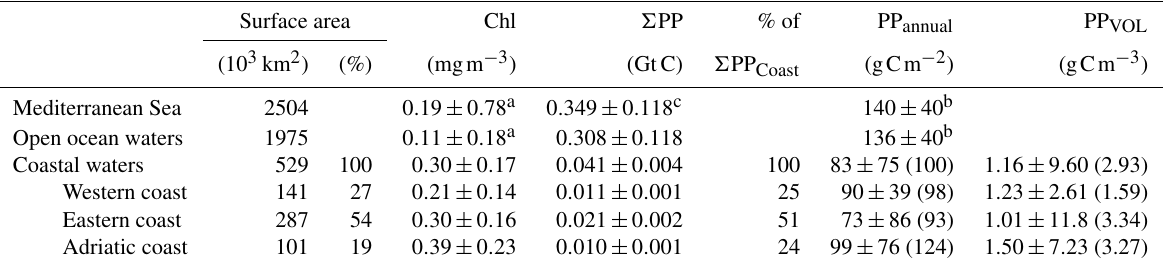
Table 2. Surface area and the corresponding basin percentage to surface area, (chl) ± standard deviation (SD), (cid:54) PP, the corresponding basin percentage to (cid:54) PP Coast (% (cid:54) PP Coast ), PP annual median ± SD (PP annual mean), and PP VOL median ± SD (PP VOL mean ) for the Mediterranean Sea, open ocean waters, and coastal waters during the period 2002–2016. For (cid:54) PP and PP annual , Mediterranean Sea values were obtained summing open ocean water values and coastal water values.